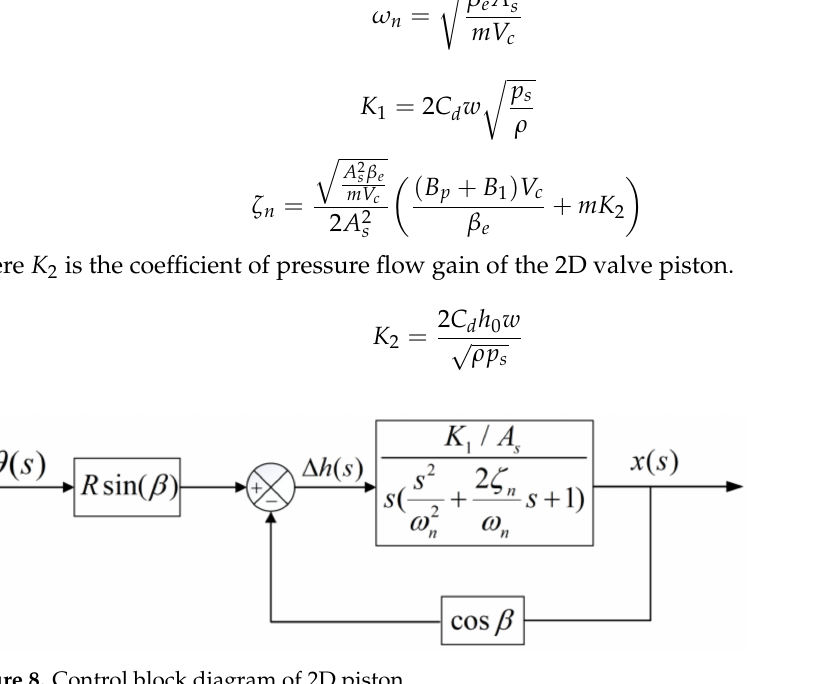
Figure 8. Control block diagram of 2D